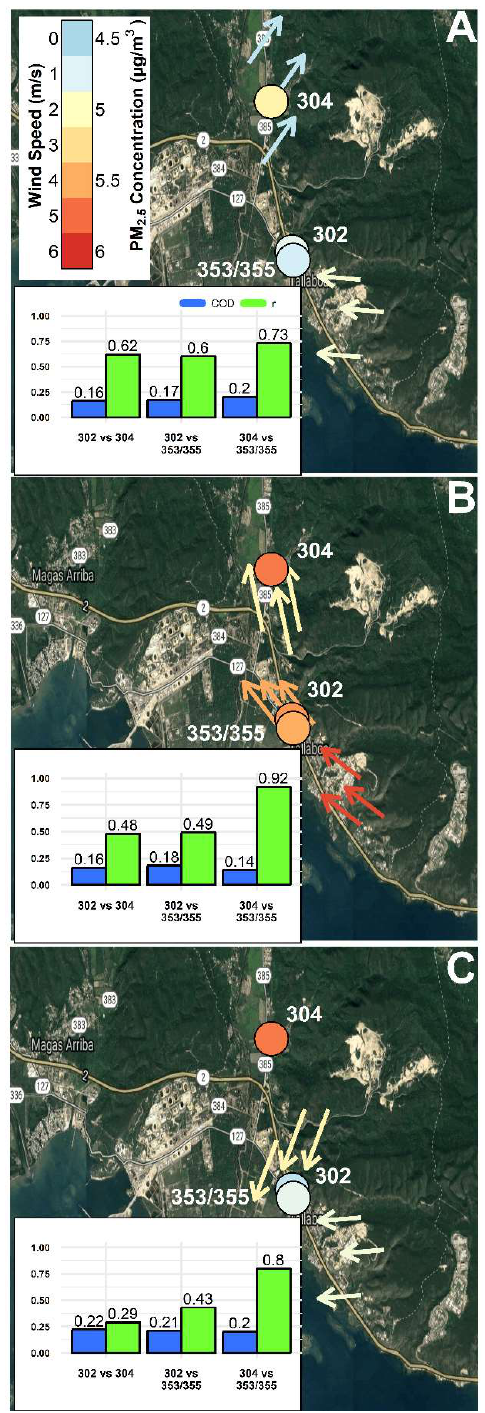
Figure 6. The change in 1 h average PM 2.5 concentrations across 3 CSAM locations (CSAMs 302, 304, and 353/355) were explored as a function of the following wind conditions observed at the South weather station: ( A ) inactive, ( B ) ocean-originated, and ( C ) mainland-originated. COD (blue bars) and r (green bars) values were recalculated in a pairwise fashion between locations for each wind condition and displayed as a bar chart in the bottom left of Figure 6A–C. Wind conditions at the South, East, and North weather stations are depicted by arrows indicating the median wind direction as a function of the conditions at the South weather station and colored by WS. Each CSAM location in Figure 6A–C are similarly colored based on pollutant concentrations.